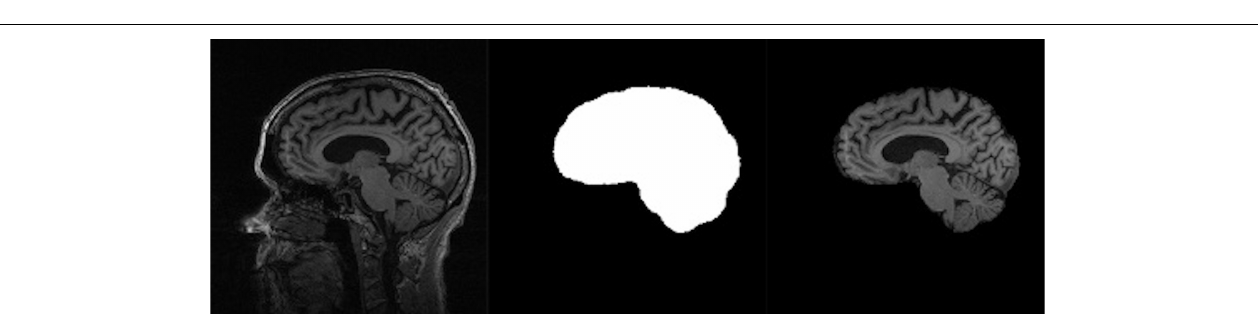
FIGURE 1 | Neural network diagram tracking 3D volume through the 5-stage encoder and fuse decoder. Convolution and ReLU layers are combined in blue arrows. Upsampling is shown by green arrows. The five stages are connected by four downsample pooling layers (red arrows) that each reduce the image by a factor of 2. The final fuse layer (green arrows) upsamples each stage output to the original image resolution and fuses them to create the prediction mask. Figure modified from Fletcher and Knaack (2020).